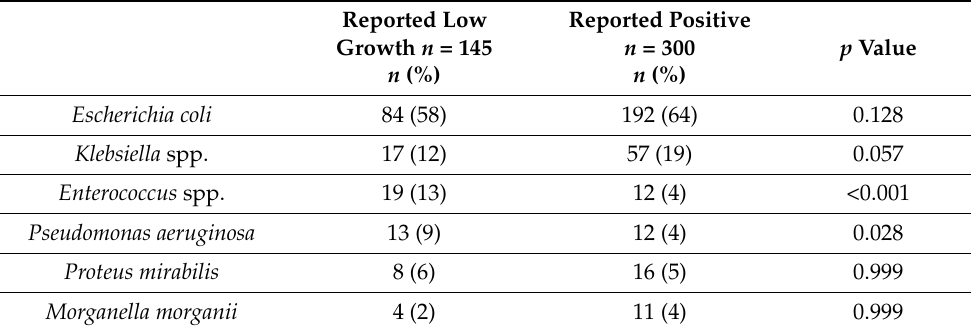
Table 3. Microbiological data of urine cultures comparing cultures reported as low growth to those reported as